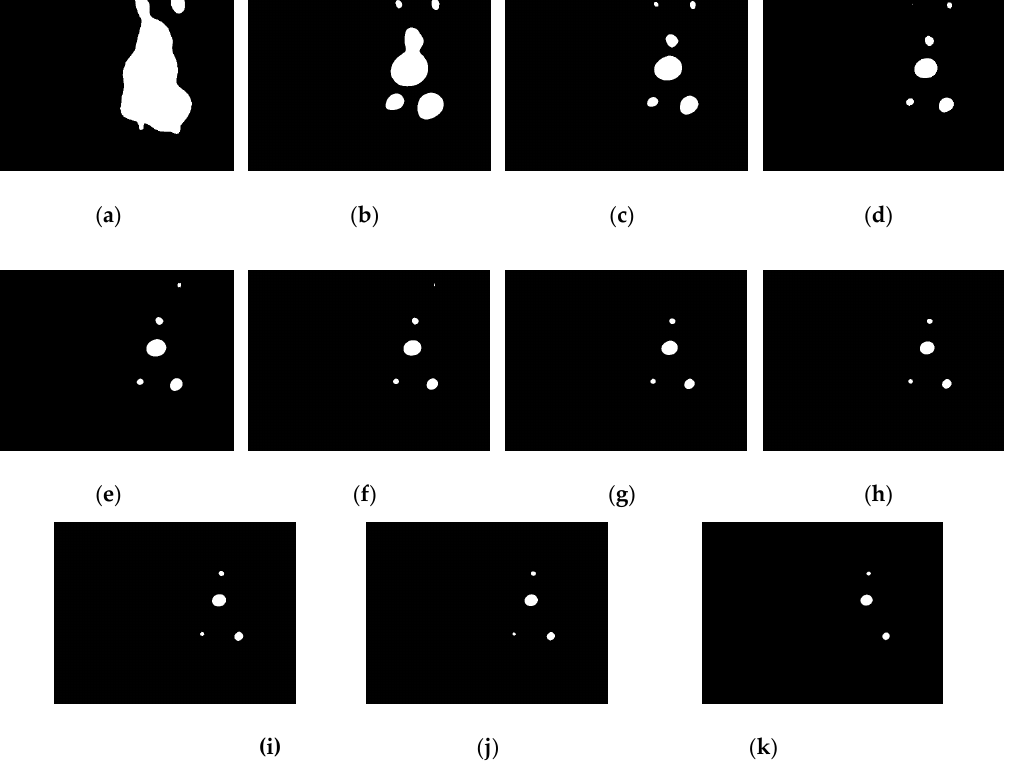
Figure 6. The procedure of the adaptively weighted OTSU method.